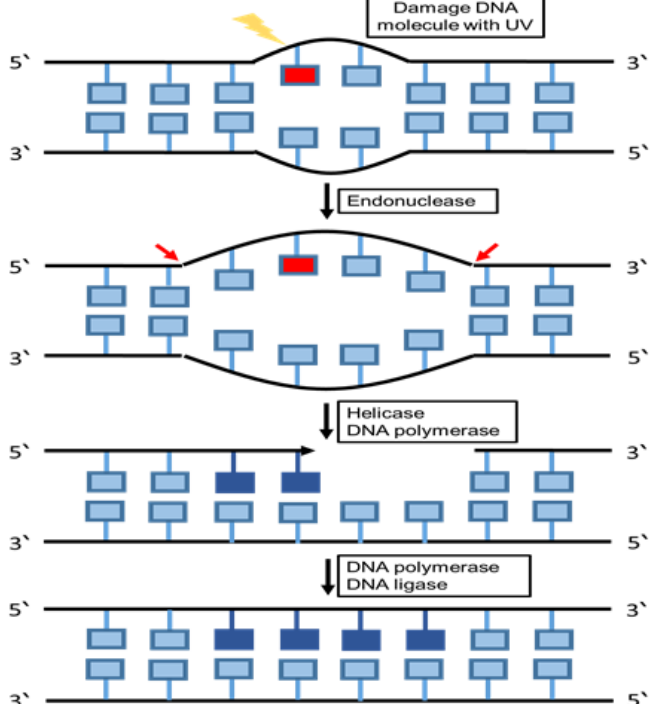
Figure 4. Nucleotide excision repair pathway. The schematic diagram summarizes the main components and the mechanism of the nucleotide excision repair pathway. In this repairing pathway the damaged bases are cut out within a sequence of nucleotides, and replaced with DNA as directed by the undamaged template strand. The nucleotides modified by bulky chemical adducts and pyrimidine dimers formed by UV radiation were removed in this repair system.